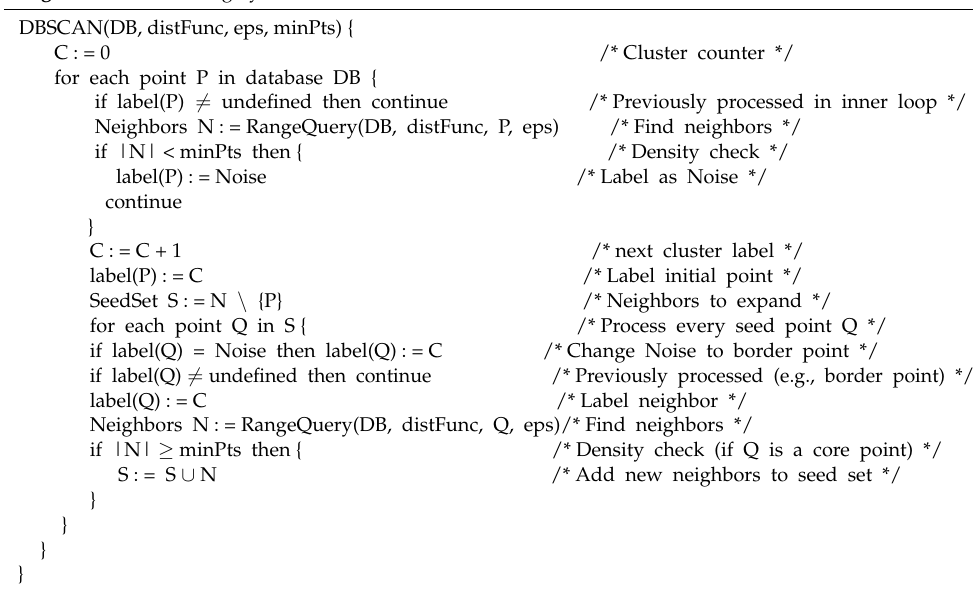
Algorithm 1. Clustering by the